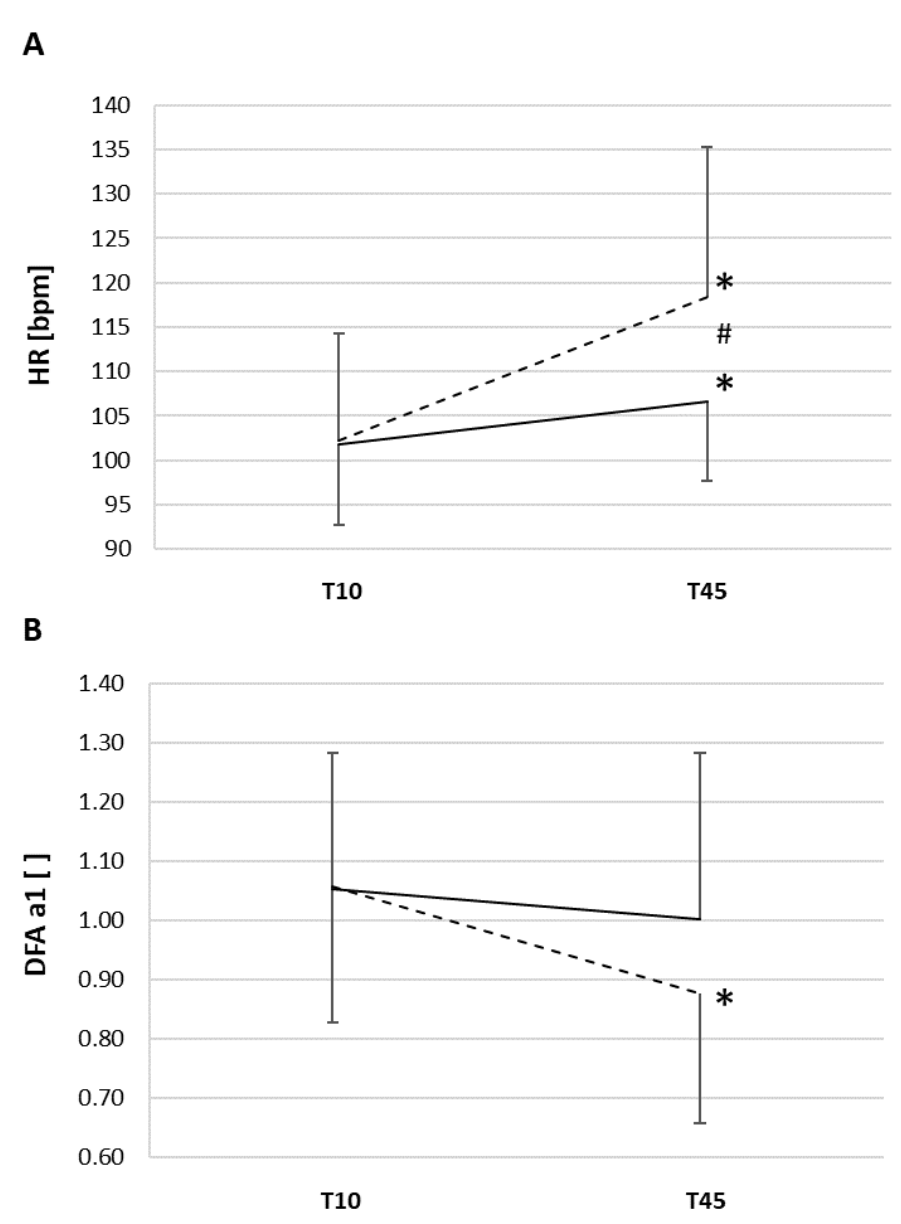
Figure 1. A: HR during ECC and CON exercise session at elapsed time 10 (T10) and 45 min (T45). B: DFA a1 during ECC and CON exercise session at elapsed time 10 (T10) and 45 min (T45). ECC: dashed line, CON: solid line, error bars represent standard deviation, * significant for direct comparison of T10 vs. T45, # significant for direct comparison of CON vs. ECC at T10 or T45. Table 2. Norepinephrine, serum lactate, and systolic and diastolic blood pressure (BP) for all participants measured at elapsed time of 45 min of either concentric (CON) or eccentric (ECC) cycling. Mean (± standard deviation, SD) listed. # significantly different from CON.